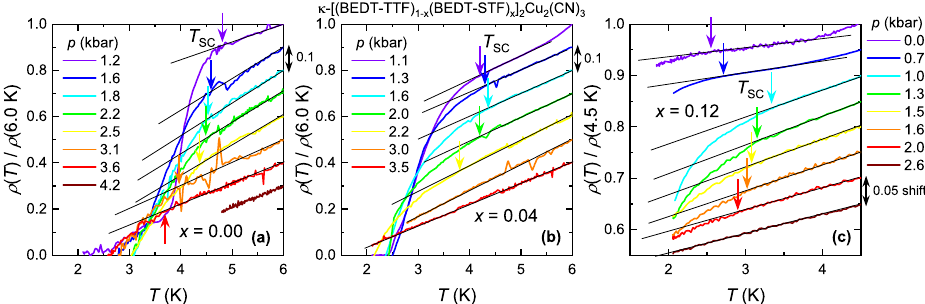
Figure 5. ( a ) Normalized electrical resistivity ρ ( T ) / ρ ( 6.5 K ) of κ -(BEDT-TTF) 2 Cu 2 (CN) 3 plotted as a function of temperature for different values of hydrostatic pressure applied, ranging from 1.2 to 4.2 kbar. The transition temperature gradually decreases for p > 1.2 kbar. ( b ) For x = 0.04, ρ ( T ) / ρ ( 6.5 K ) reveals an initial increase of T SC , followed by a reduction until it is fully suppressed. ( c ) The dome-like increase of transition temperature with pressure is even more pronounced for x = 0.12 ( ρ ( T ) normalized to 4.5 K). For clarity, the curves in all panels are shifted vertically with respect to each